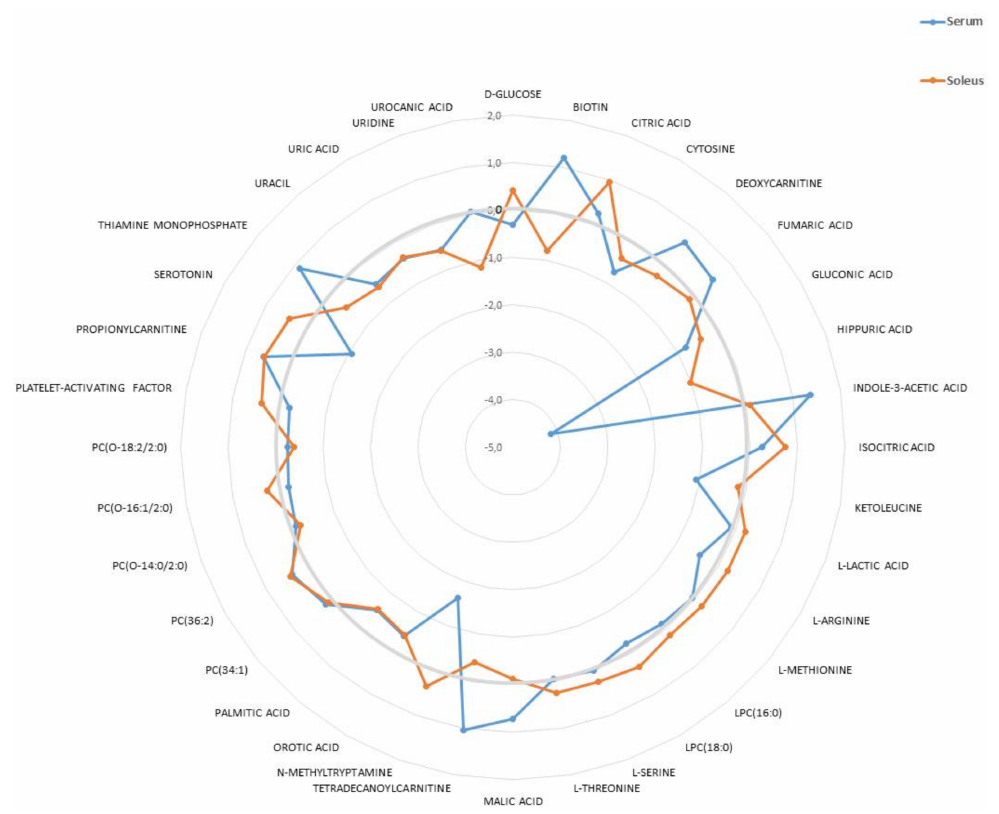
Figure 7. Radar diagram of the 36 VIP found to be common in serum and soleus. Metabolites showed up or downregulation following the bold grey circle giving the zero-base line. Values are given according to log2(FC) of metabolites in serum (blue line) and soleus (red line),